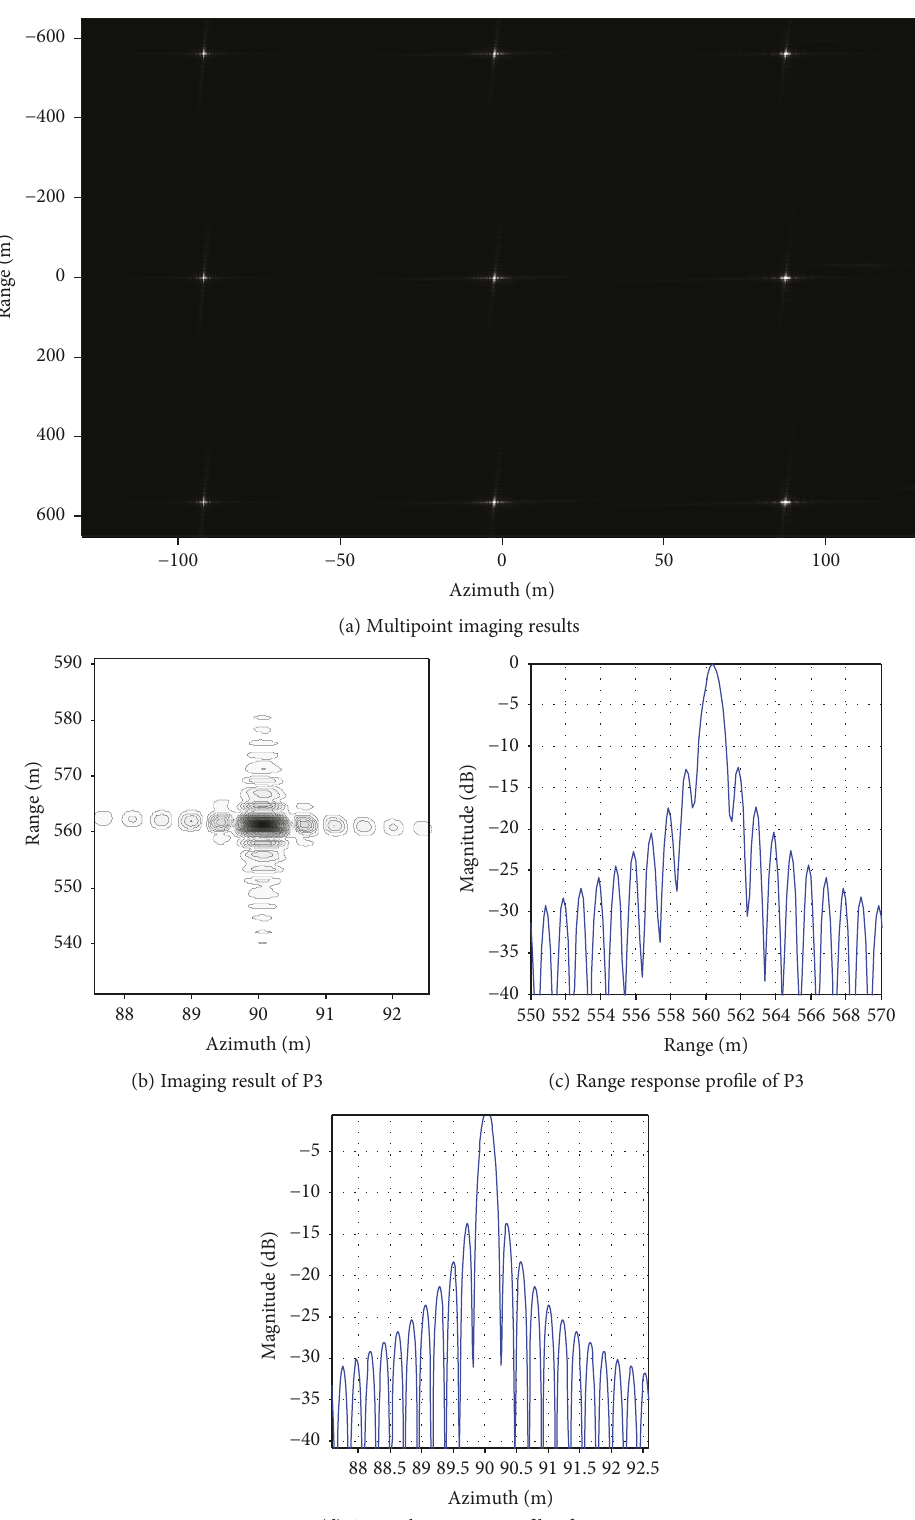
Figure 6: Imaging results in the spotlight mode of the